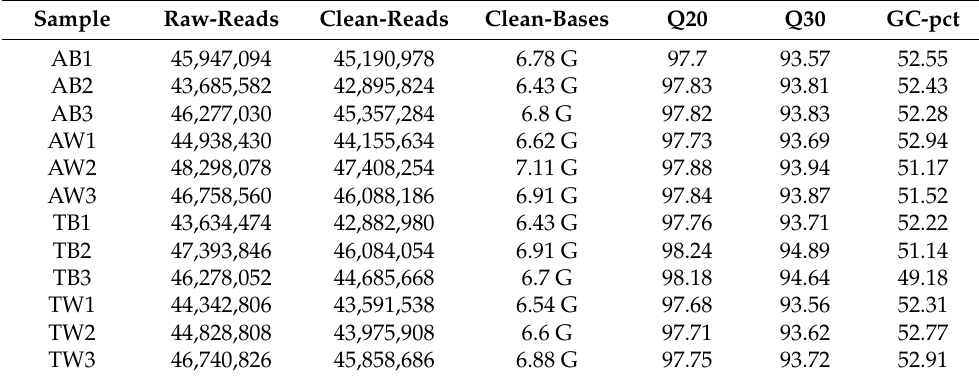
Table 1. Sequencing data